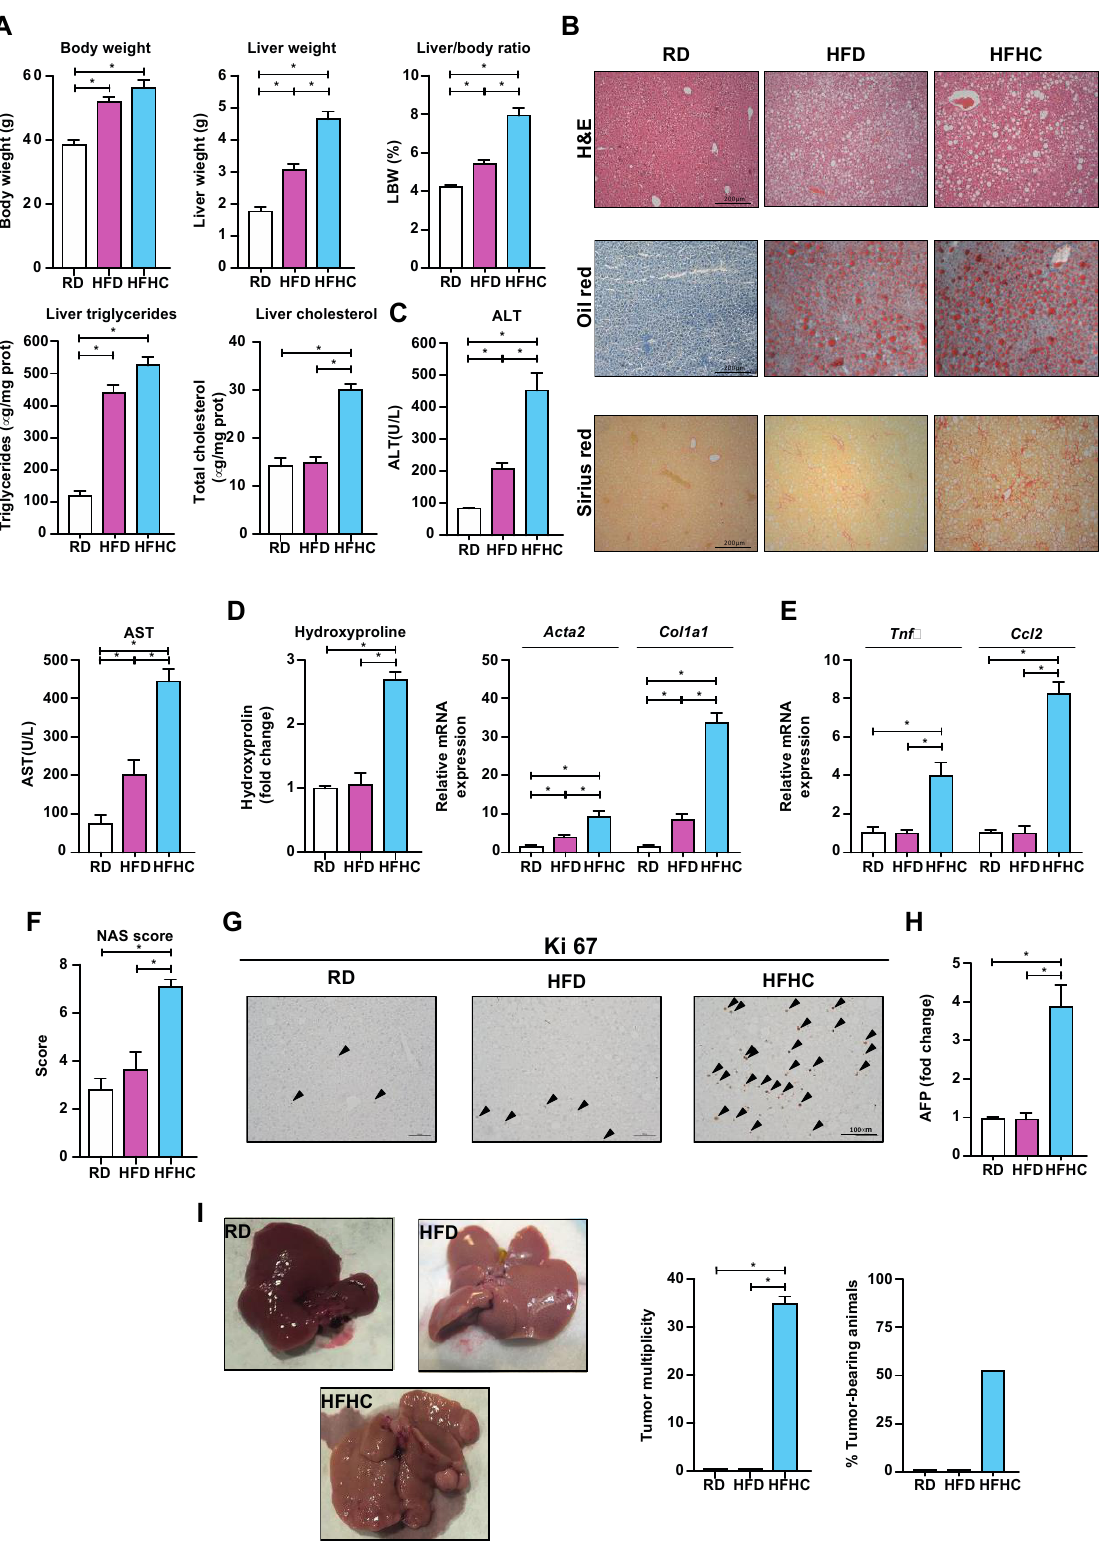
Figure 4. C57BL/6J mice of 6 weeks of age were introduced to RD, HFD, or HFHC feeding without any carcinogenic treatment for 10 months. The number of animals per group: RD (9), HFD (10), and HFHC (10). ( A ) The animal body weight, liver weight, relative liver weight, hepatic triglyceride, and cholesterol composition after 10 months on the specified diets.